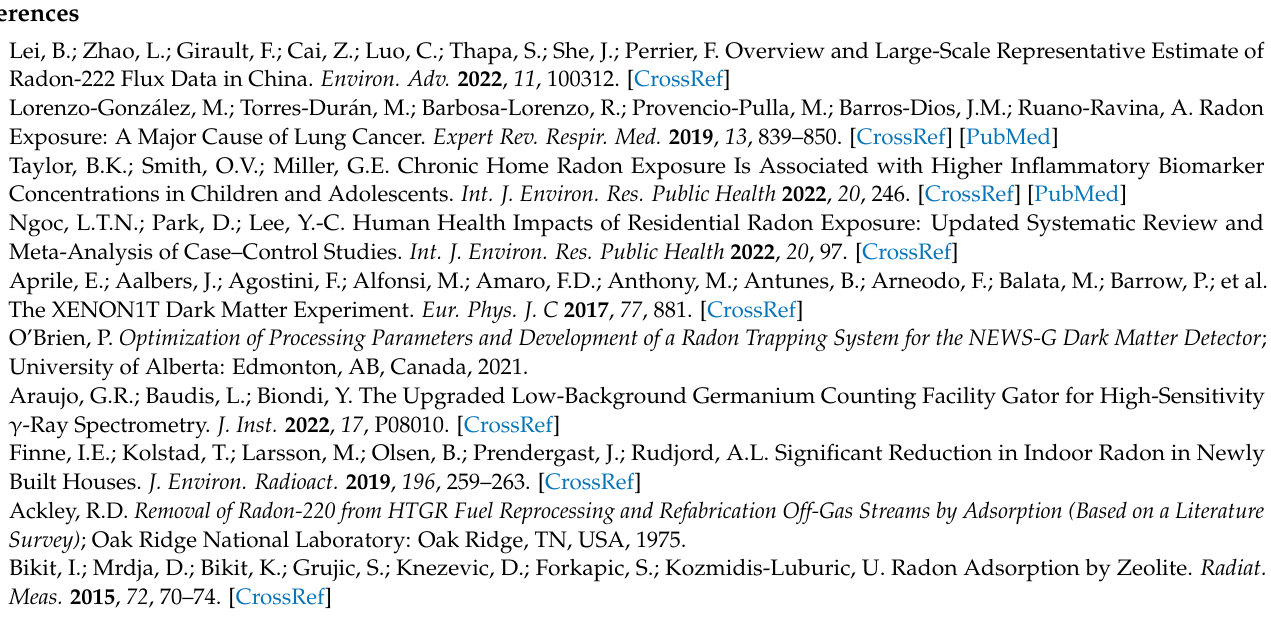
Figure S2. SEM/energy dispersive X − ray spectroscopy mappings of interior of Ni − MOF − 74@PA − PEI, Figure S3. N − MOF − 74 (after tableting), Figure S4. 2 adsorption/desorption isotherms of Ni X − ray diffraction patterns of several